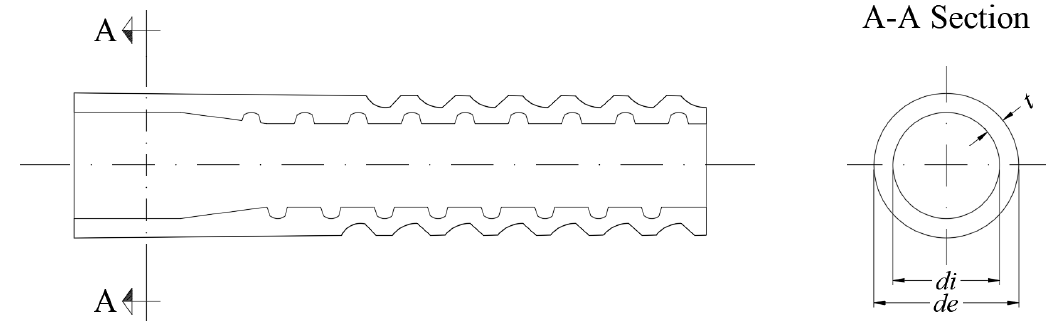
Figure 2. Detail of polymeric dowels.